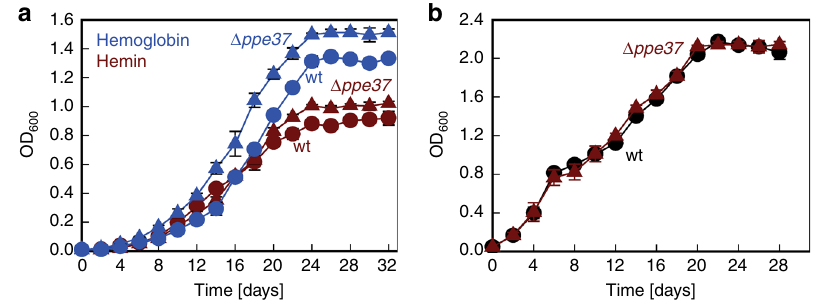
Fig. 2 Characterization of the M. tuberculosis Δ ppe37 mutant. a Growth of avirulent Mtb strain mc 2 6206 (wt; circles) and Δ ppe37 mutant (triangles) in HdB minimal medium with 10 µ M hemin (red) or 2.5 µ M human hemoglobin (blue). b Growth of avirulent Mtb strain mc 2 6206 (wt; black circles) and Δ ppe37 (red triangles) in HdB minimal medium with 0.5% bovine serum albumin and 10 µ M hemin. All media contained 20 µ M of 2,2 ′ -dipyridyl to prevent utilization of trace iron. Error bars represent standard errors of mean values of biological triplicates. Source data are provided in the Source Data fi